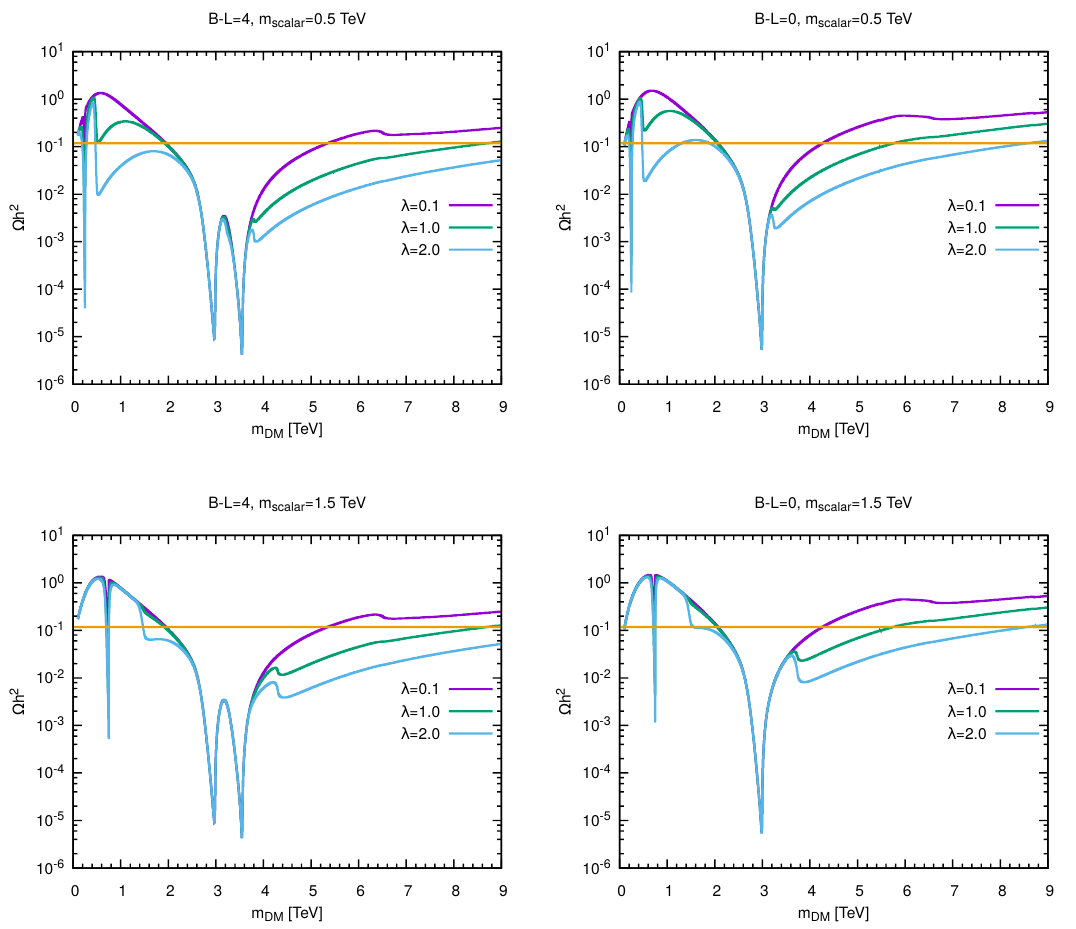
Figure 2 . Relic density as a function of the dark matter mass. The left panel is for B (cid:0) L = 4 case, whereas the right panel is for B (cid:0) L = 0 case. The upper (lower) panels are for the scalar mass 0.5 TeV (1.5 TeV). In all the panels, we take M W